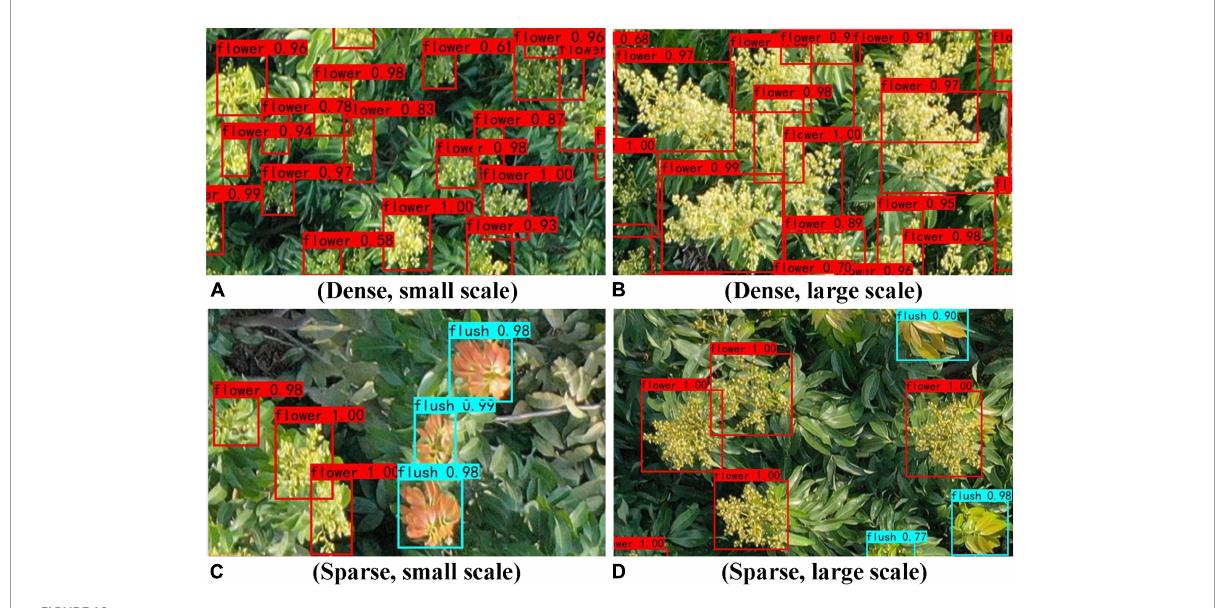
FIGURE10 Results of YOLOv4 model detection obtained under different sparseness conditions.